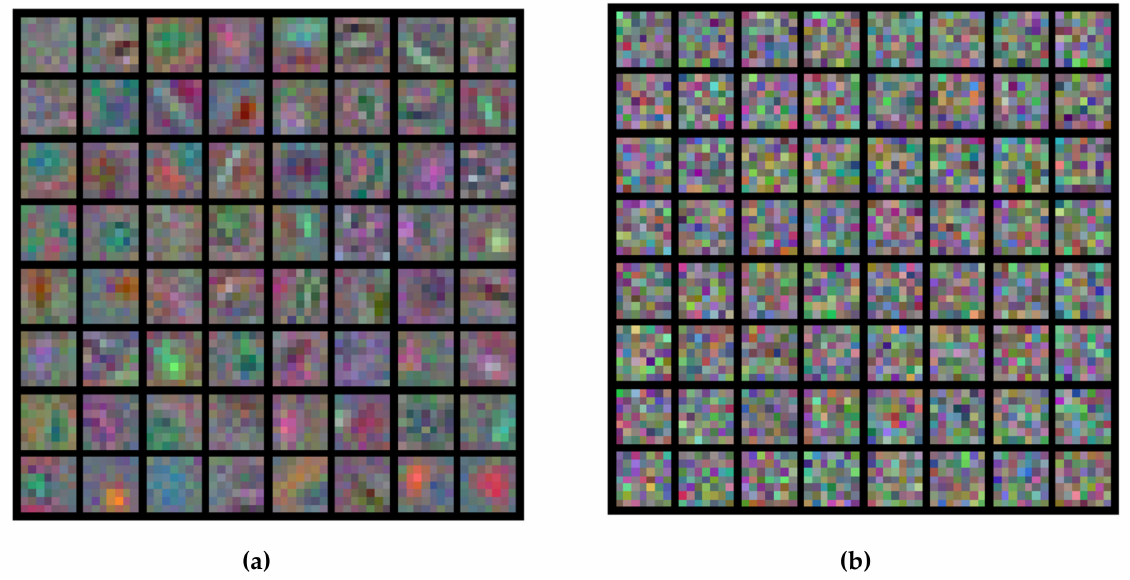
Figure 13. Weights for the first convolutional layer for ResNet18 used for the classification of the thin-section data: ( a ) ResNet18 trained on MSI vs. MSS; ( b ) same weights after the model is fine-tuned on the thin-section